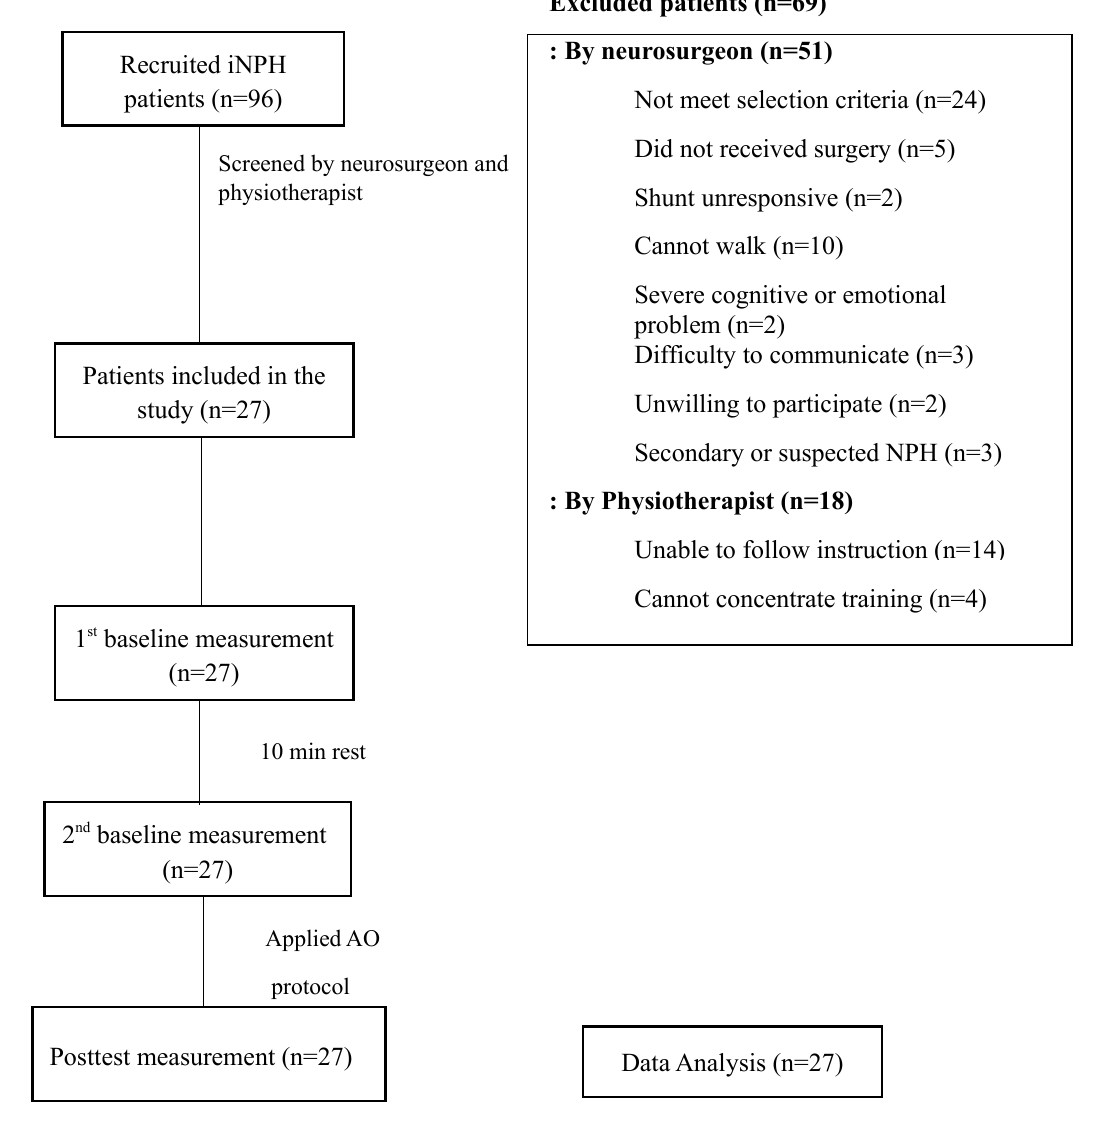
Figure 1. Flowchart of the study.